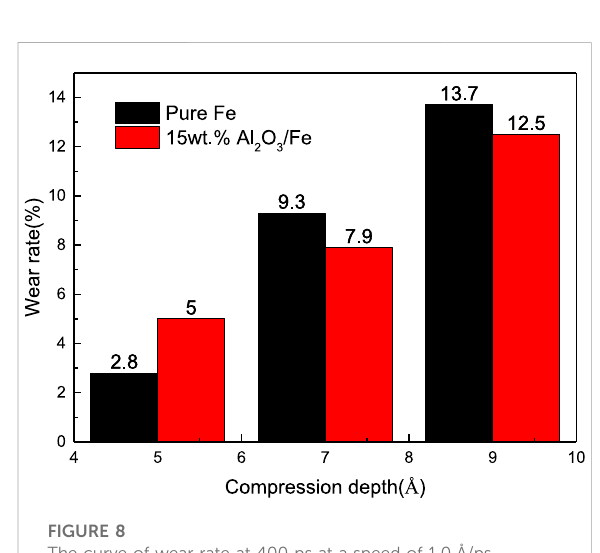
FIGURE 8 The curve of wear rate at 400 ps at a speed of 1.0